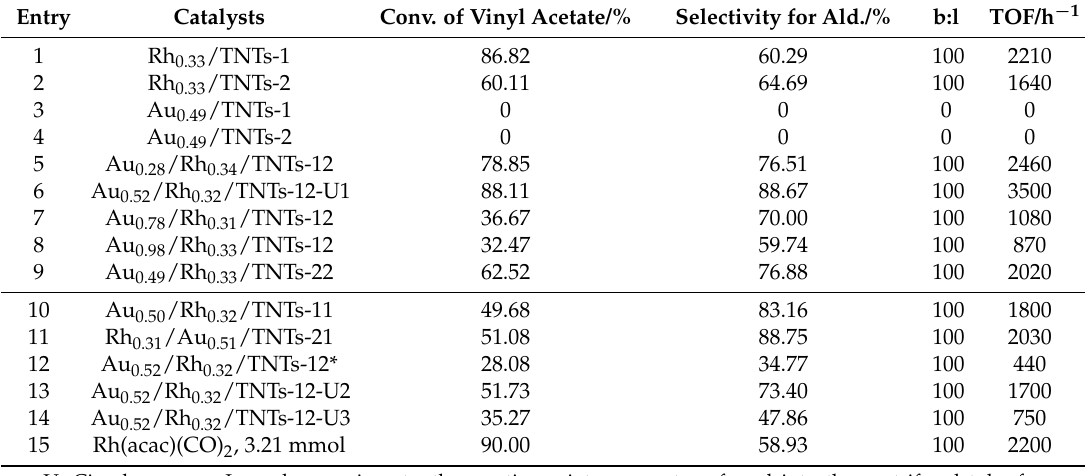
Table 2. Reaction results of vinyl acetate hydroformylation using prepared catalysts.